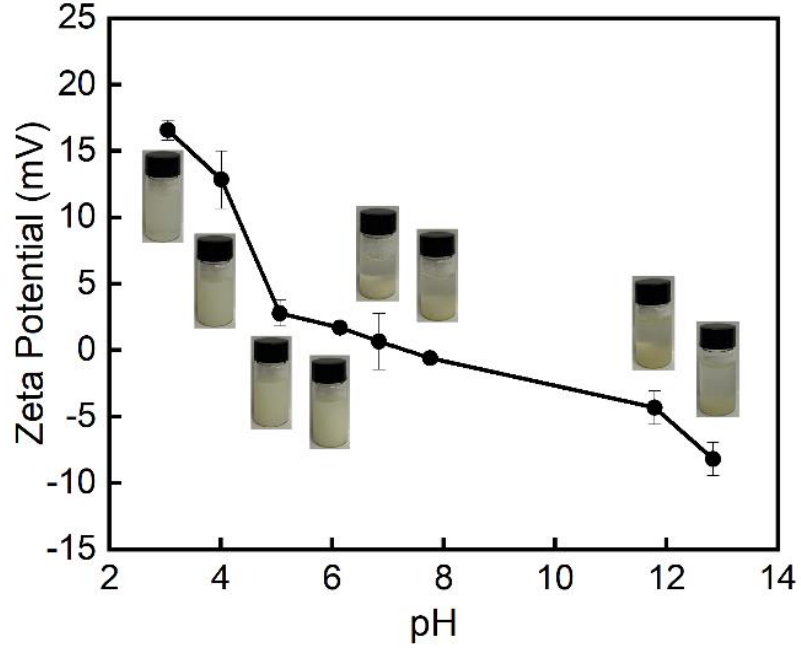
Figure 5. The zeta potential of CS-PA-CD nanoparticles on different pH values.